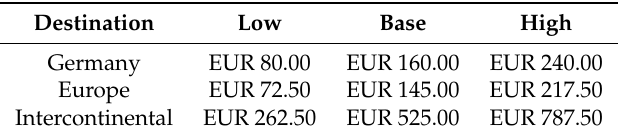
Table 4. Assumed ticket prices for rebooking passengers from Frankfurt Airport. Additionally, the prices are multiplied with M to consider different cooperation levels (see Table